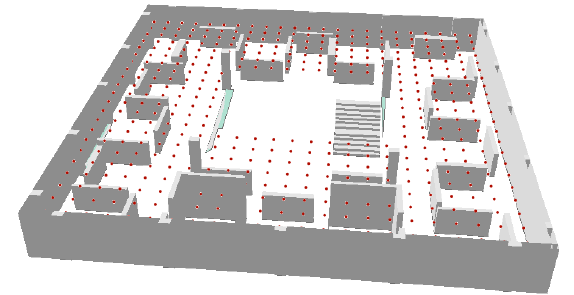
Figure 6. Source and Target points for the visibility